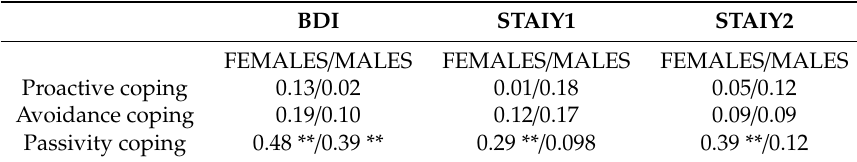
Table 8. Coping strategies, depression, anxiety: Pearson bivariate correlations in female ( n = 117) and male ( n = 63)